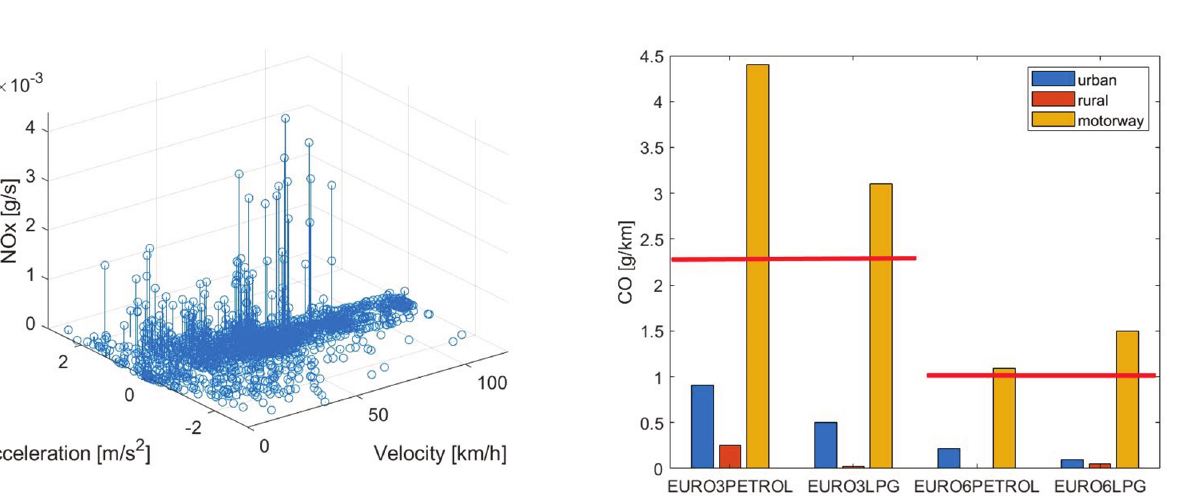
Fig, 16. Specific distance emission of CO for selected parts of road tests (red line is emission limit)